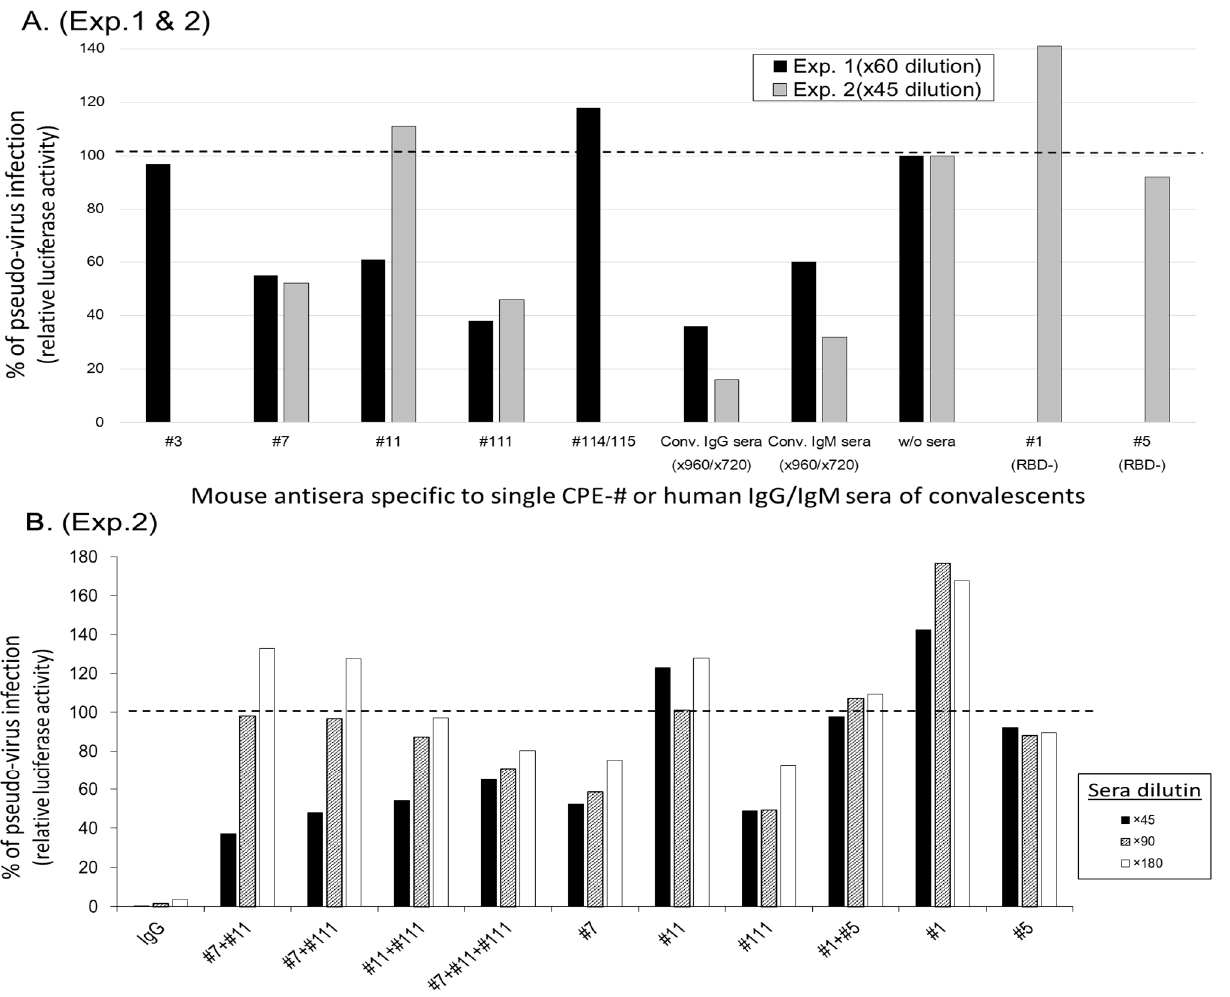
Figure 3. Protective ability of epitope-specific antisera in SARS-CoV-2 pseudo-virus infection. ( A ) Pseudo-virus infection and inhibition by mouse sera immunized with multi CPEs-Ag. In exp. 1 (black bars), mouse sera at 60-fold dilution were assessed in the pseudo-virus infection system of SARS-CoV-2 Spike molecule. The #7, #11 and #111 CPEs-specific antisera but not #3 and #114/#115 CPEs-specific antisera inhibited this pseudo-virus infection. The exp. 2 (gray bars) was conducted with 45-fold dilution. As controls, convalescents’ sera were set in parallel at 960-fold dilution (black bars) in exp. 1 and 720-fold dilution (gray bars) in exp.2. ( B ) The sera dilution-dependent inhibition of pseudo-virus infection. In exp. 2, two or three sera specific to individual neutralizing epitopes (#7, #11 and #111) or non-neutralizing epitopes (#1 and #5) were mixed equally, then the mixed sera were diluted to culture media and added at final dilutions of 45-, 90- and 180-fold to see inhibition against the pseudo-virus infection.